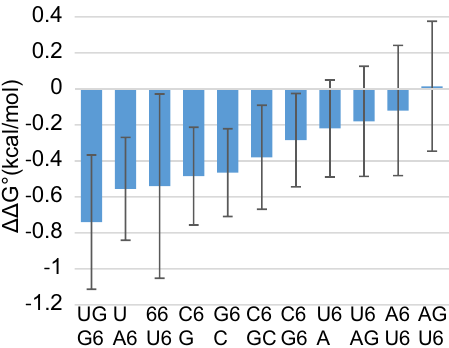
Fig. 3 M 6 A stacking on a helix end stabilizes secondary structure as compared to A stacking. The ΔΔ G° 37 (kcal/mol) for dangling ends and terminal mismatches as a result of N 6 -methylation (Supplementary Table S4) is shown, where negative values mean greater folding stability for m 6 A than A. The motifs shown here have a terminal base pair (left side of motif), and either a dangling end or terminal mismatch right (right side of motif). On average, the methylated motifs are more stabilizing than the unmethylated motifs, although the extent of the stabilization is sequence dependent. Uncertainty estimates are propagated from the uncertainty from the individual optical melting experiments (see “ Error propagation ” in the “ Methods ” ). Two fi ndings support this. First, when a terminal parameter is included in the linear regression fi t, the value is + 0.13 ± 0.17 kcal/ mol, which is not signi fi cantly different from 0 kcal/mol. Second, our dataset includes two helices with the same nearest neighbor stacks,